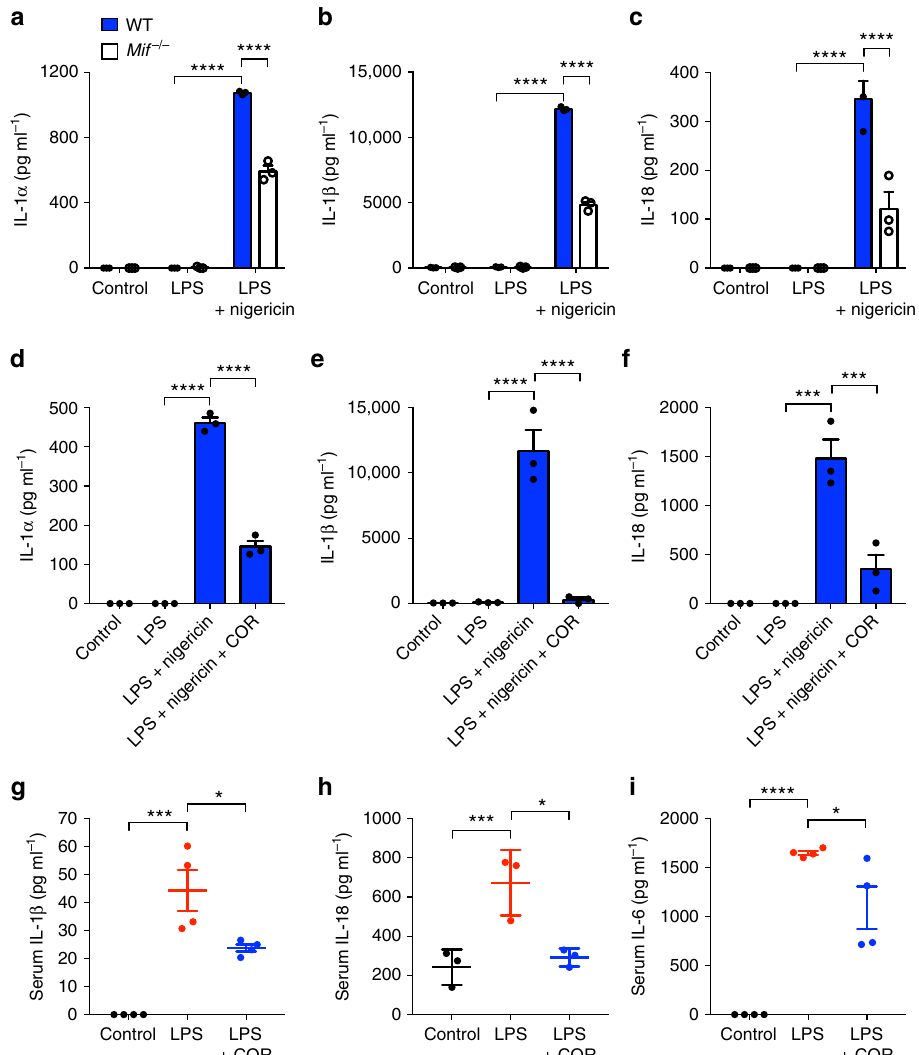
Fig. 1 MIF is required for the release of IL-1 family cytokines. Primary murine WT and Mif − / − BMDMs were left untreated (control), primed with LPS (10 ng ml − 1 ), or primed with LPS followed by nigericin (5 µ M) treatment for 1 h. Levels of a IL-1 α , b IL-1 β , and c IL-18 in cell culture supernatants were assessed by ELISA. Primary WT BMDMs were left untreated, primed with LPS alone (10 ng ml − 1 ), primed with LPS, and then treated with or without COR123625 (50 µ M) for 2 h before the addition of nigericin (5 µ M) for 1 h. Levels of d IL-1 α , e IL-1 β , and f IL-18 in cell culture supernatants were assessed by ELISA. C57BL6/J mice were injected intraperitoneally with vehicle control (saline), LPS alone (2 mg kg − 1 ) or COR123625 (20 mg kg − 1 ) in combination with LPS for 2 h. Serum levels of g IL-1 β , h IL-18, and i IL-6 were measured by ELISA. Data are expressed as means ± SEM, n = 3 – 4 mice per group. * P < 0.05, *** P < 0.005, **** P < 0.001, one-way ANOVA with a correction provided by the Tukey's multiple comparisons (Fig. 1i), possibly suggesting effects on cells other than macrophages, different signaling pathways, or knock-on effects of IL-1 inhibition in macrophages/DCs. However, LPS-induced elevation of serum IL-6 was not signi fi cantly inhibited in Mif − / − mice (Supplementary Figure 4F). Serum IL-1 β , on the other hand, was signi fi cantly lower in Mif − / − mice, compared to WT mice (Supplementary Figure 4G).